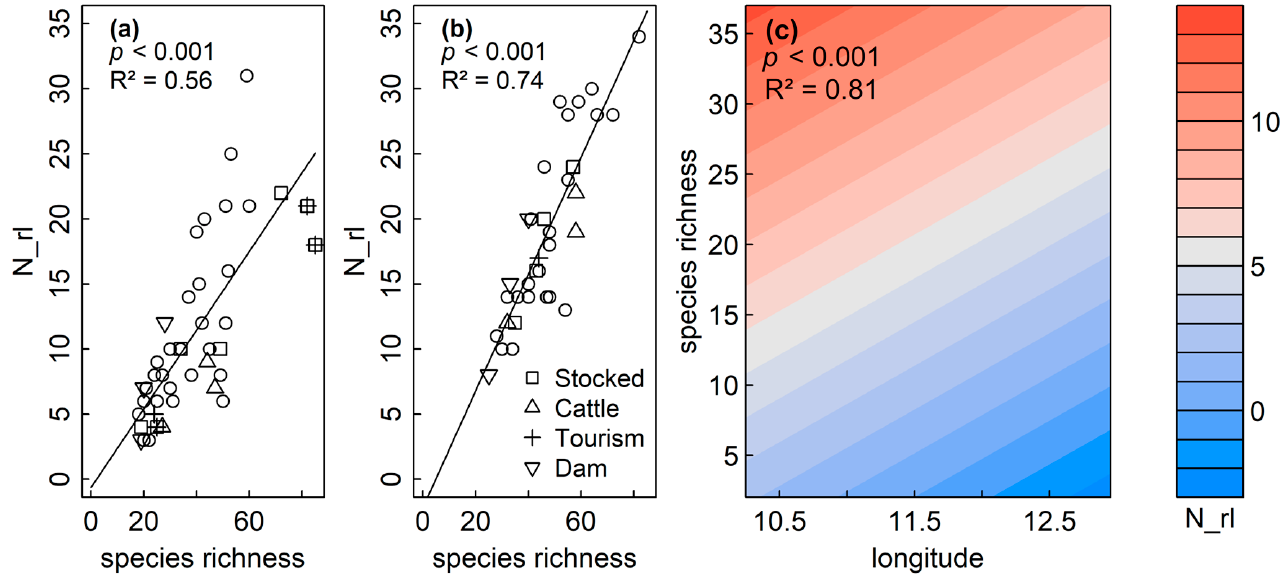
Figure 5. The number of Red List species (N_rl) increased with species richness for sedimentary ( a ), littoral ( b ) and planktic ( c ) assemblages. Longitude (lon) was additionally negatively correlated to N_rl for planktic assemblages. The color indicates the number of RL taxa.